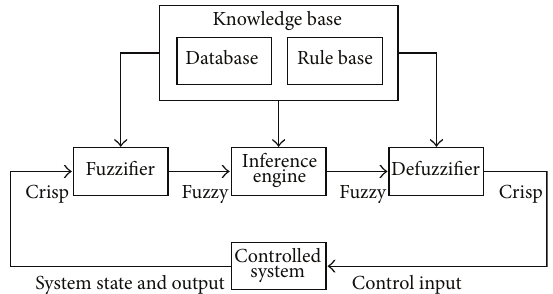
Figure 1: Fuzzy logic controller